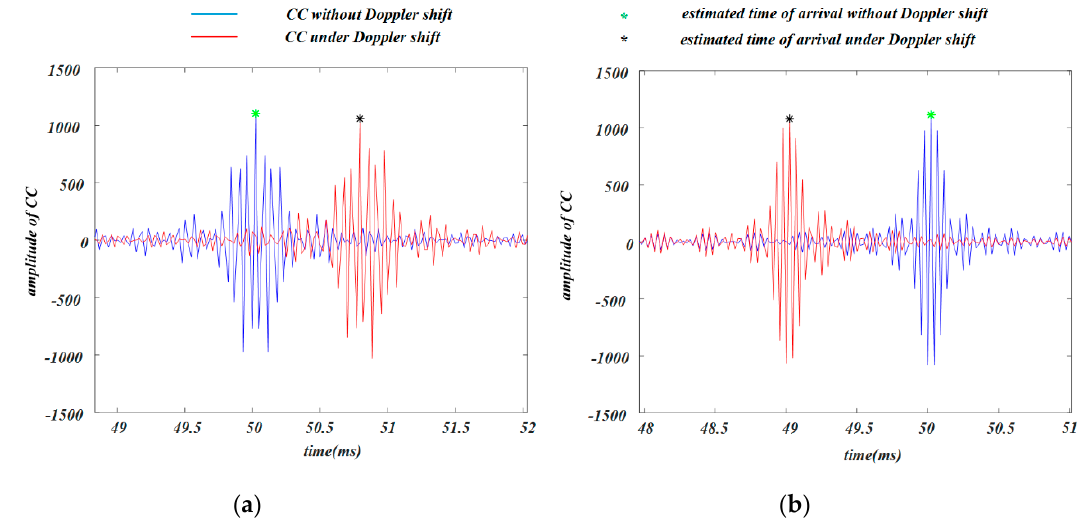
Figure 7. Simulation results of influences of Doppler shift on arrival time detection. ( a ) 18–15 kHz chirp signal; ( b ) 19–22 kHz chirp signal. chirp signal; ( b ) 19–22 kHz chirp